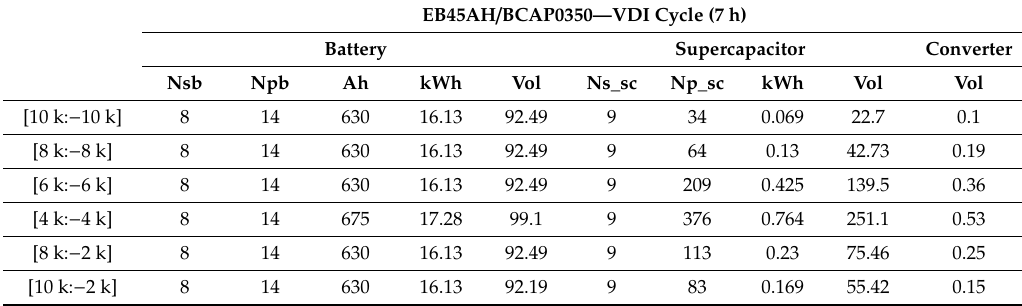
Figure 11. Weight results according to different power battery limits. Table 5. Results from energy management test (number of cells, capacity and volume).